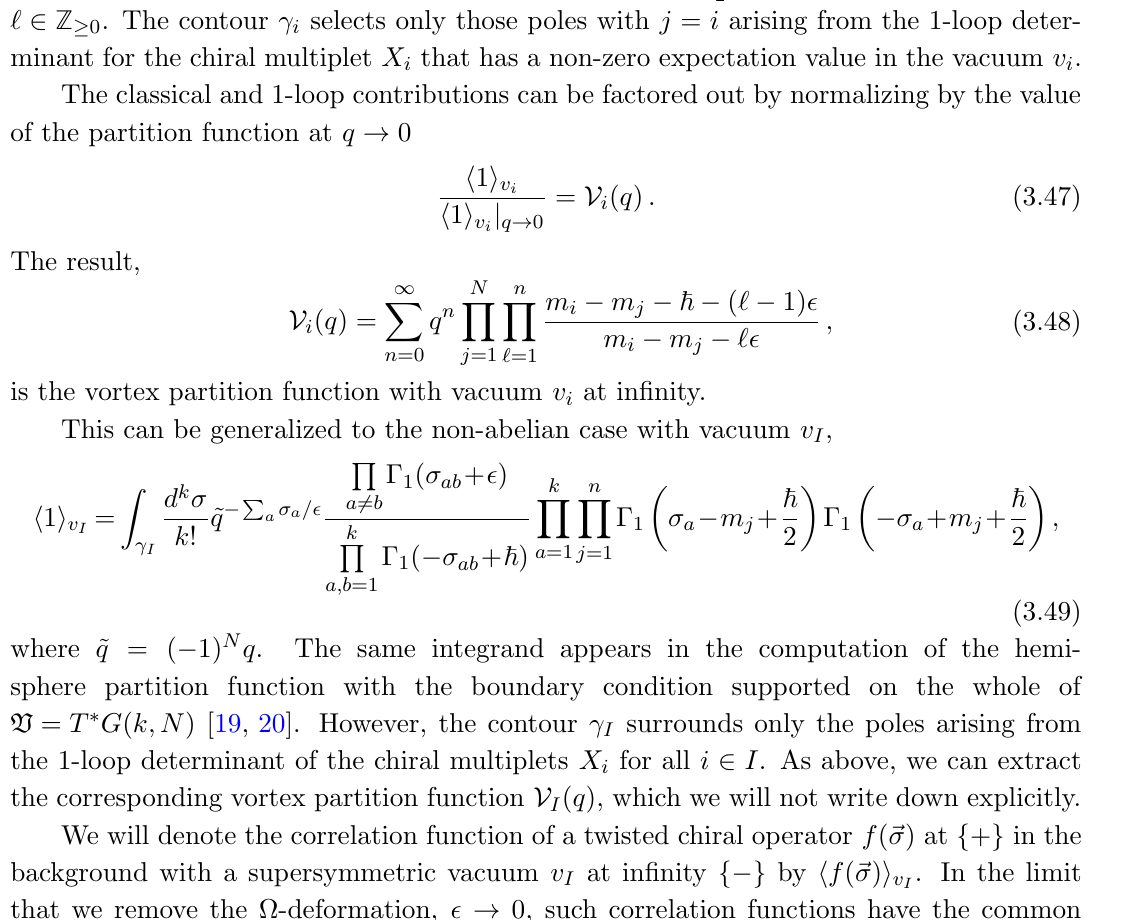
J isometry and vacuum . f(cid:0)g ~ ‘(cid:15) for all j = 1 ; : : : ; N 2 (cid:0) (cid:0)